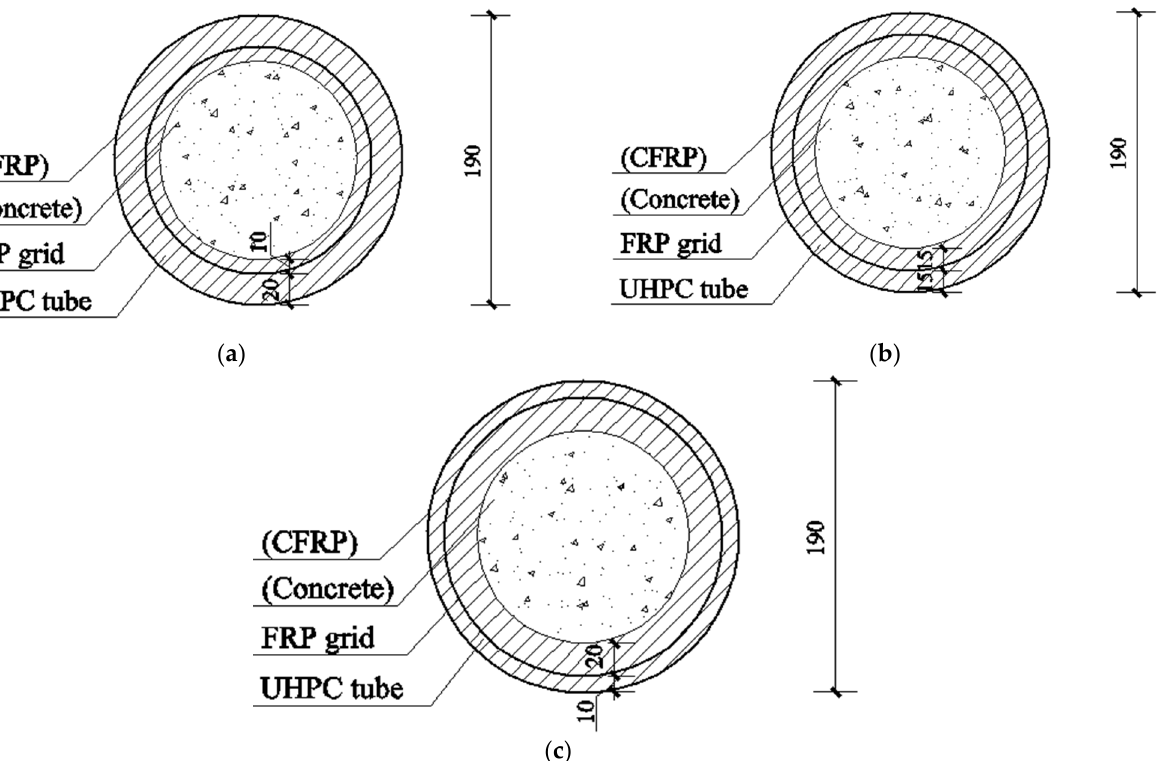
Figure 2. Dimensions of specimens (unit: mm). ( a ) Position A ( d grid = 150 mm); ( b ) Position B ( d grid = 160 mm); ( c ) Position C ( d grid = 170